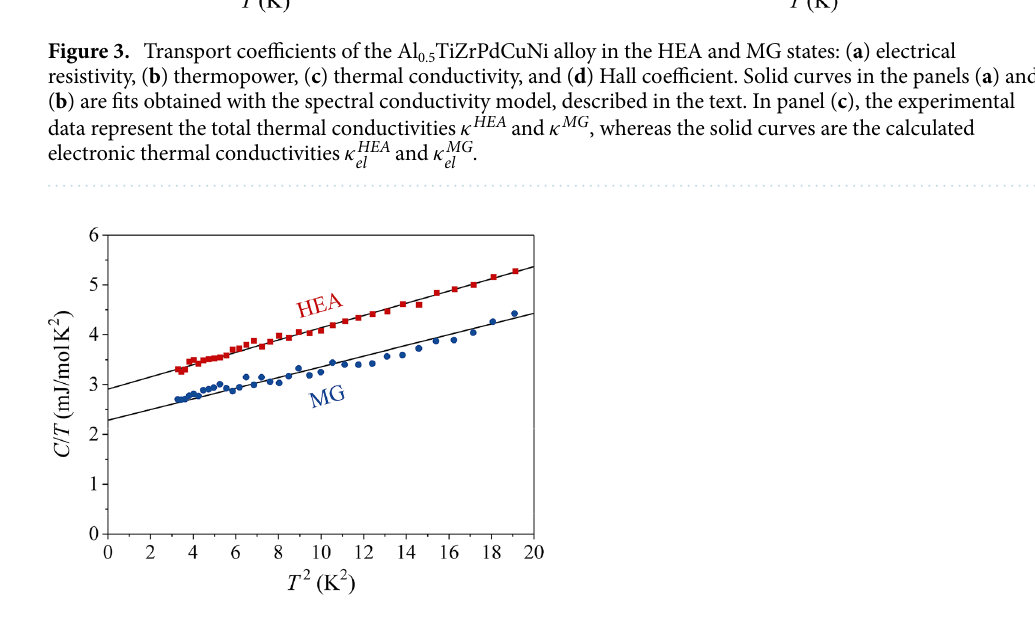
Figure 4. Low-temperature specific heat of the HEA and MG samples in a C / T vs. T 2 plot. Solid lines are fits with the expression C / T = γ + α T 2 , and the fit parameters are given in the